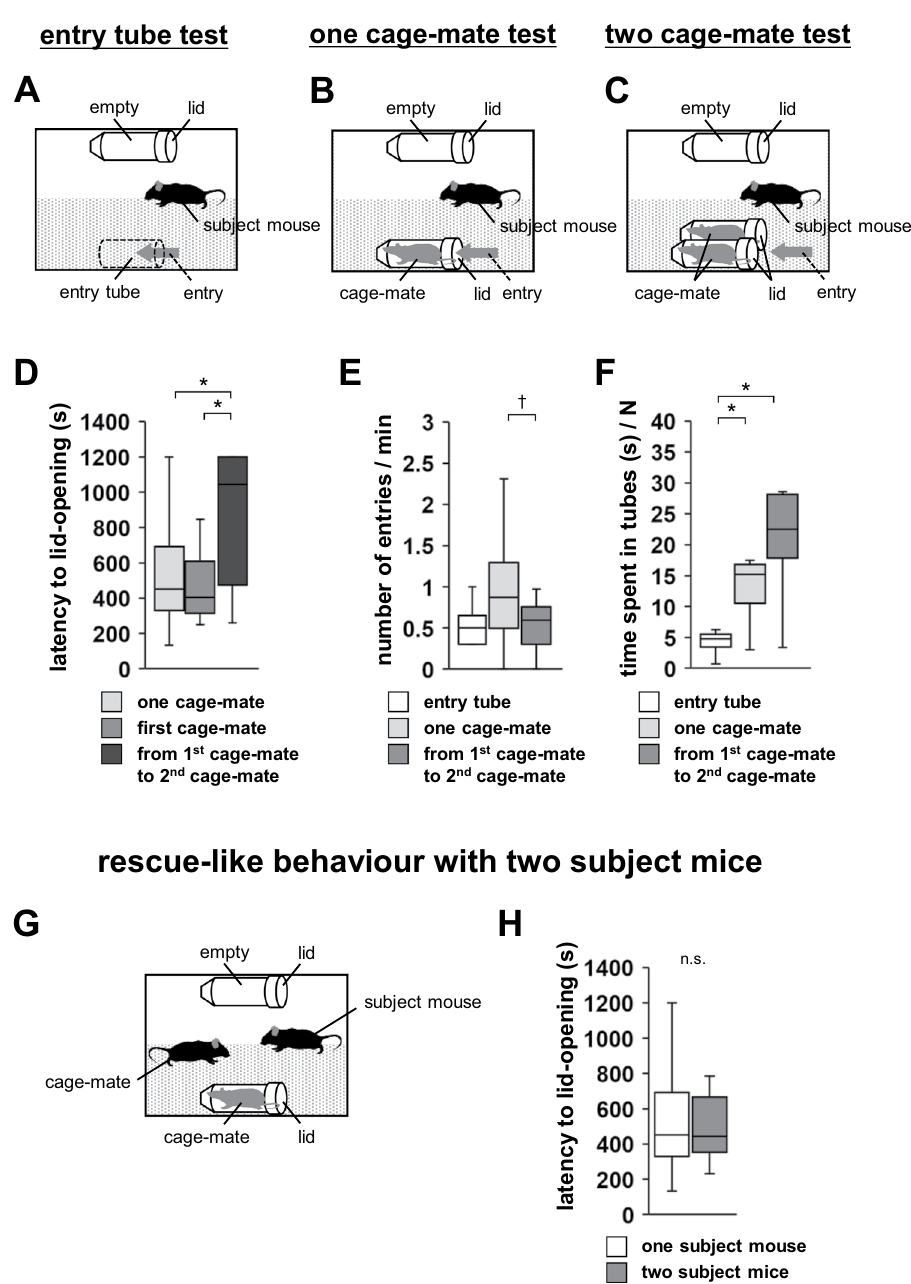
Figure 5. Rescue-like behaviour test towards two cage-mates constrained inside tubes. ( A – C ) Schematic diagrams of the tests. ( C ) Two tubes containing cage-mate mice on one side of the cage. Rescue-like behaviour test for two cage-mates: latency to lid-opening ( D ), number of entries to the tubes ( E ), and time spent in tubes ( F ) in this test. ( G ) Schematic diagram of the rescue-like behaviour test with two subject mice. ( H ) Comparison of the latency to lid-opening. Statistical significance is represented as: † p < 0.1 and * p < 0.05. n.s., not significant. The p values were calculated by one-way repeated measures ANOVA ( D – F , H ). n = 10 animals per